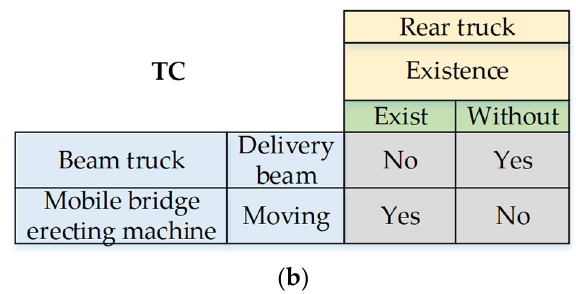
( f ) Figure 24. ( a ) Conflict C 1 ; ( b ) Conflict C 2 ; ( c ) Conflict C 3 ; ( d ) Conflict C 4 ; ( e ) Conflict C 5 ; ( f ) Conflict C 6 . 4.4. Problem-Solving in Complicated Problem Area 4.4.1. Building Conflict Network Based on conflicts extracted from problems in the preliminary solution, a multi-con- flicts parameter network is established, as shown in Figure 25.